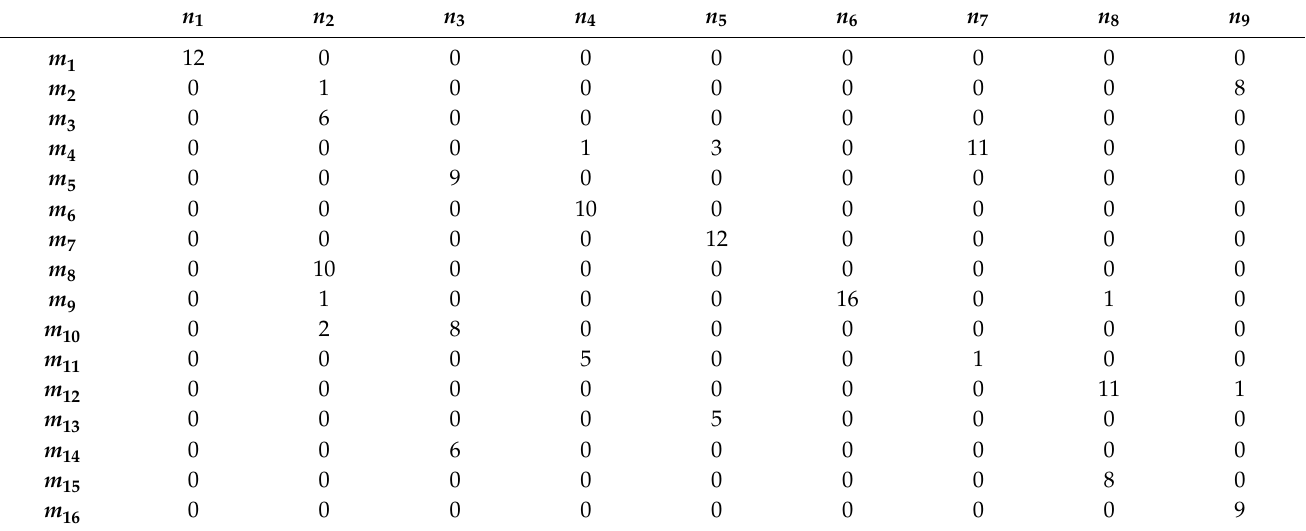
Table 8. Values of decision variables (Variant #1,